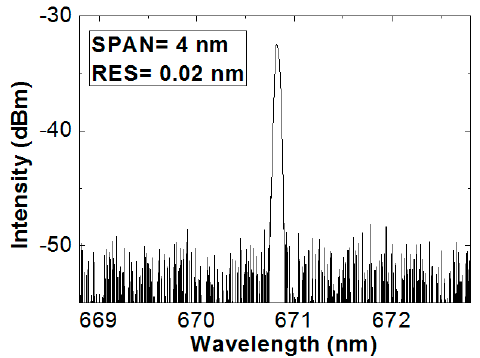
Figure 3. The optical spectrum of the external-cavity master oscillator.